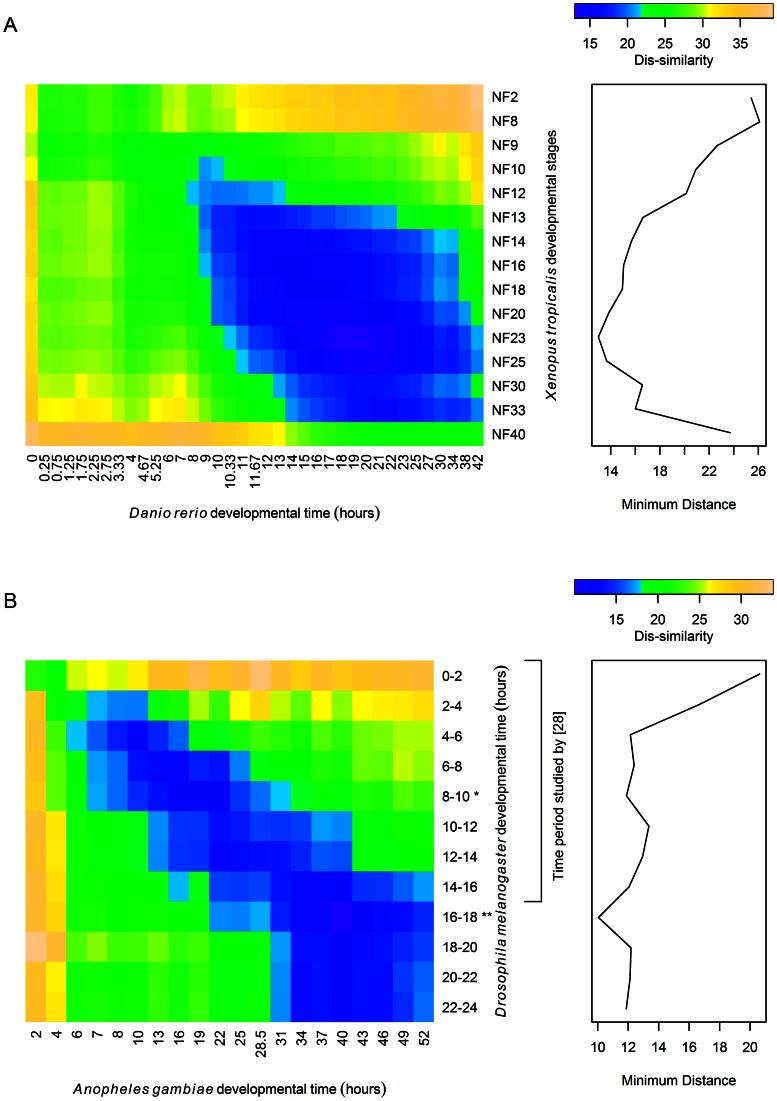
Similarity of TF transcriptomes between species.Heatmaps showing the similarity of the TF transcriptome at all time points for (a) Xenopus tropicalis and Danio rerio and (b) Drosophila melanogaster and Anopheles gambiae. Darker blue/violet shading indicates that the TF trancriptomes for the two species at the given times during development are more similar. The profiles on the right shows the minimum distance between (a) each time piont of Xenopus tropicalis and any time point in Danio rerio and (b) each time point of Drosophila melanogaster and any time point in Anopheles gambiae. In (b), the bracketed time periods for Drosopila are those included in the study by Kalinka et al. (2010) that showed that the time period between 8–10 hours is when the transcriptomes of different Drosophila species are most similar. That time period (indicated by a *) is a local maximum for TF transcriptome similarity between the two insects considered in this study; the 16–18 hour time period for Drosophila melanogaster (indicated by a **) is the time period with the greatest TF transcriptome similarity to Anopheles gambiae.